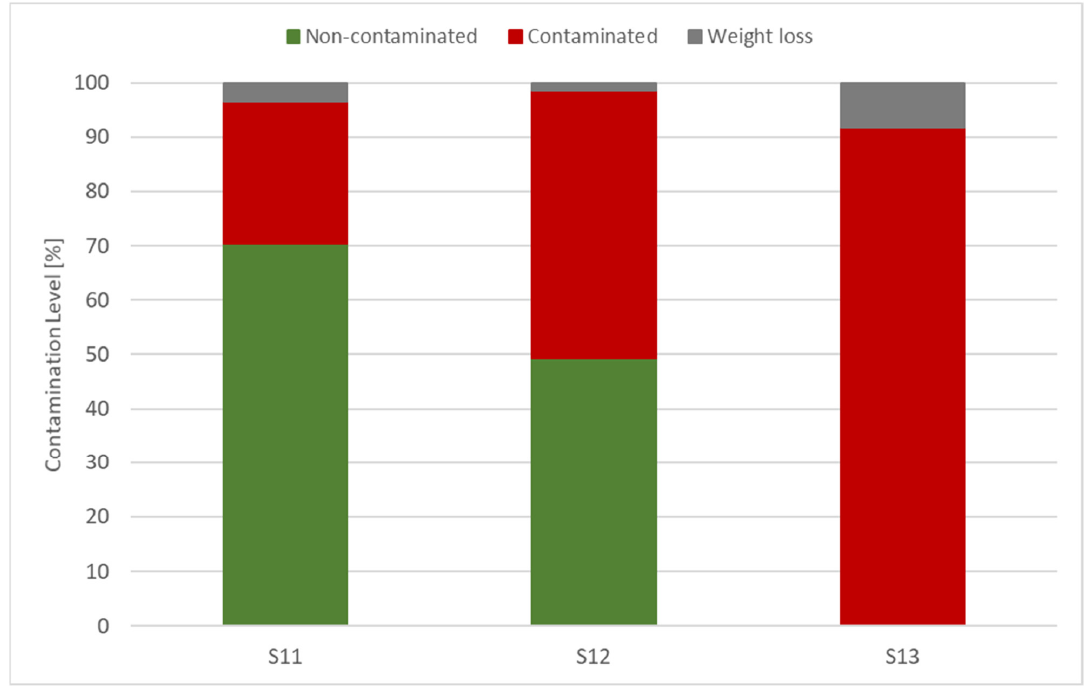
Figure A6. Contamination level of carbon residues by C/S analyses (assuming a provisional limit value of 0.1 wt% for the carbon residues).